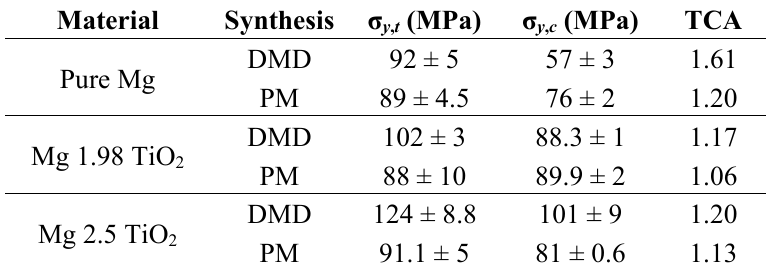
Figure 9. Fractographs after compressive loading of PM synthesized ( a ) pure Mg, ( b ) Mg 1.98 TiO 2 and ( c ) Mg 2.5 TiO 2 . Table 9. Room temperature Tensile–Compression Asymmetry (TCA) of the synthesized pure M and Mg-TiO 2